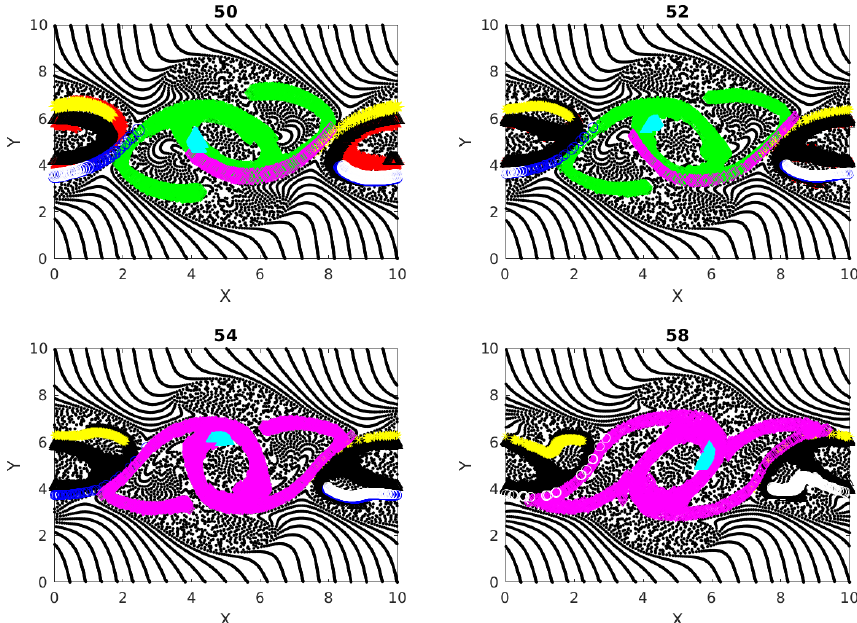
Figure 3. Cumulative clusters identified at time 50 with threshold distance for interaction (cid:15) = 40% of initial separation of particles on uniform rectangular grid and their evolution tracked at later time steps (52, 54 and 58). Changing colors denote the merging of two clusters when particles from two clusters